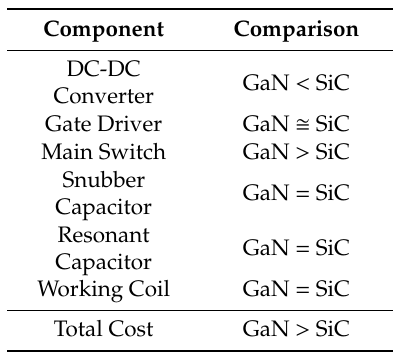
Table 3. Comparison of system components.